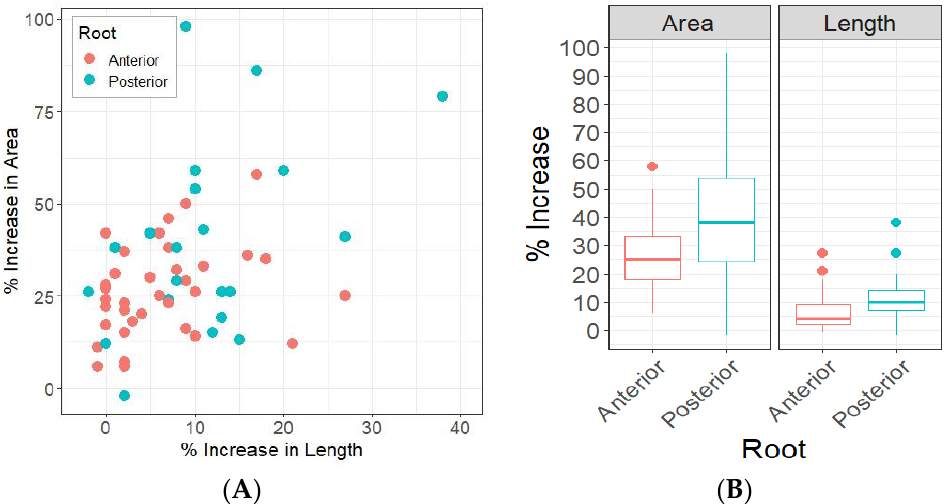
Figure 6. The relative increase (in percentages) in root length and RRA (radiographic root area). ( A ) scatterplot of increase in area vs increase in length; ( B ) individual distributions shown as boxplots. Coral and blue circles represent anterior and posterior roots, respectively.